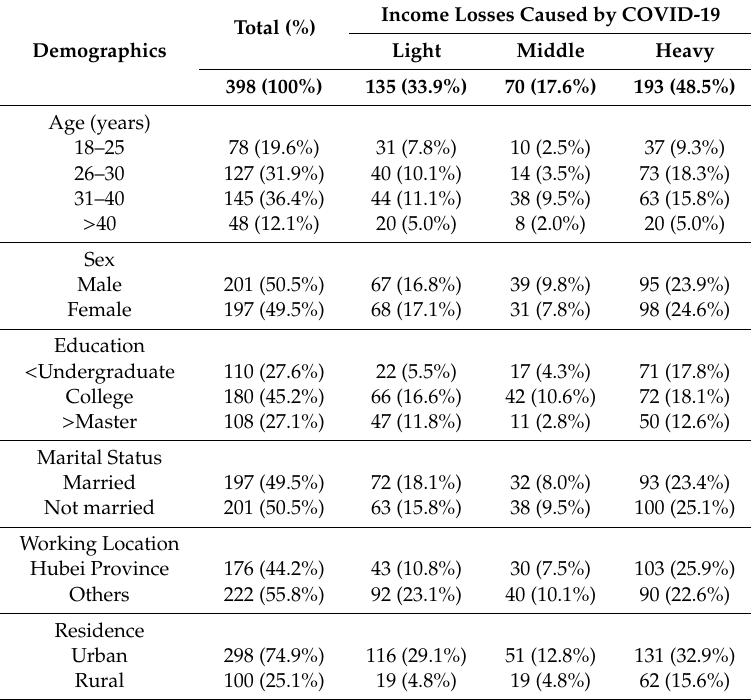
Table 1. Demographic and occupational characteristics of